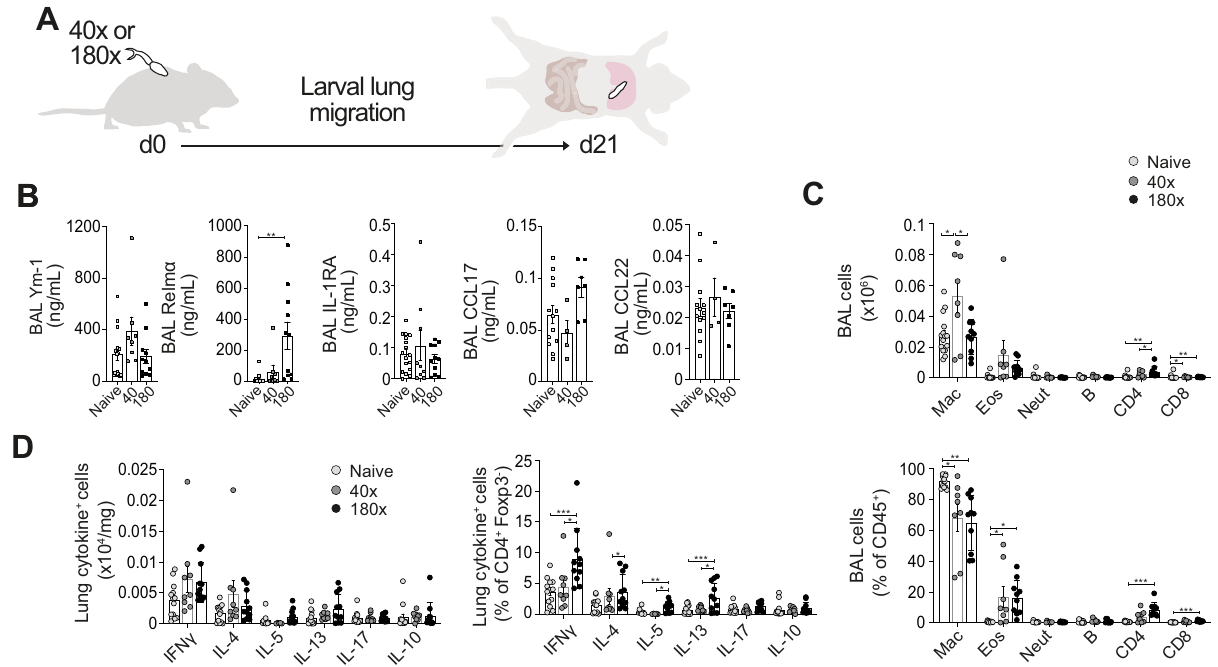
assessed via fl ow cytometry. Data are from 4 independent experiments ( n =33 biologicallyindependentanimals).Datawere fi ttoalinearmixedeffectmodel,with experimentaldayasa random effectvariable, and groupswith a two-sided Tukey ’ s multiple comparison test. * p <0.05, ** p <0.01, *** p <0.001. Data are presented as mean values ± SEM. Source data are provided as a Source Data fi